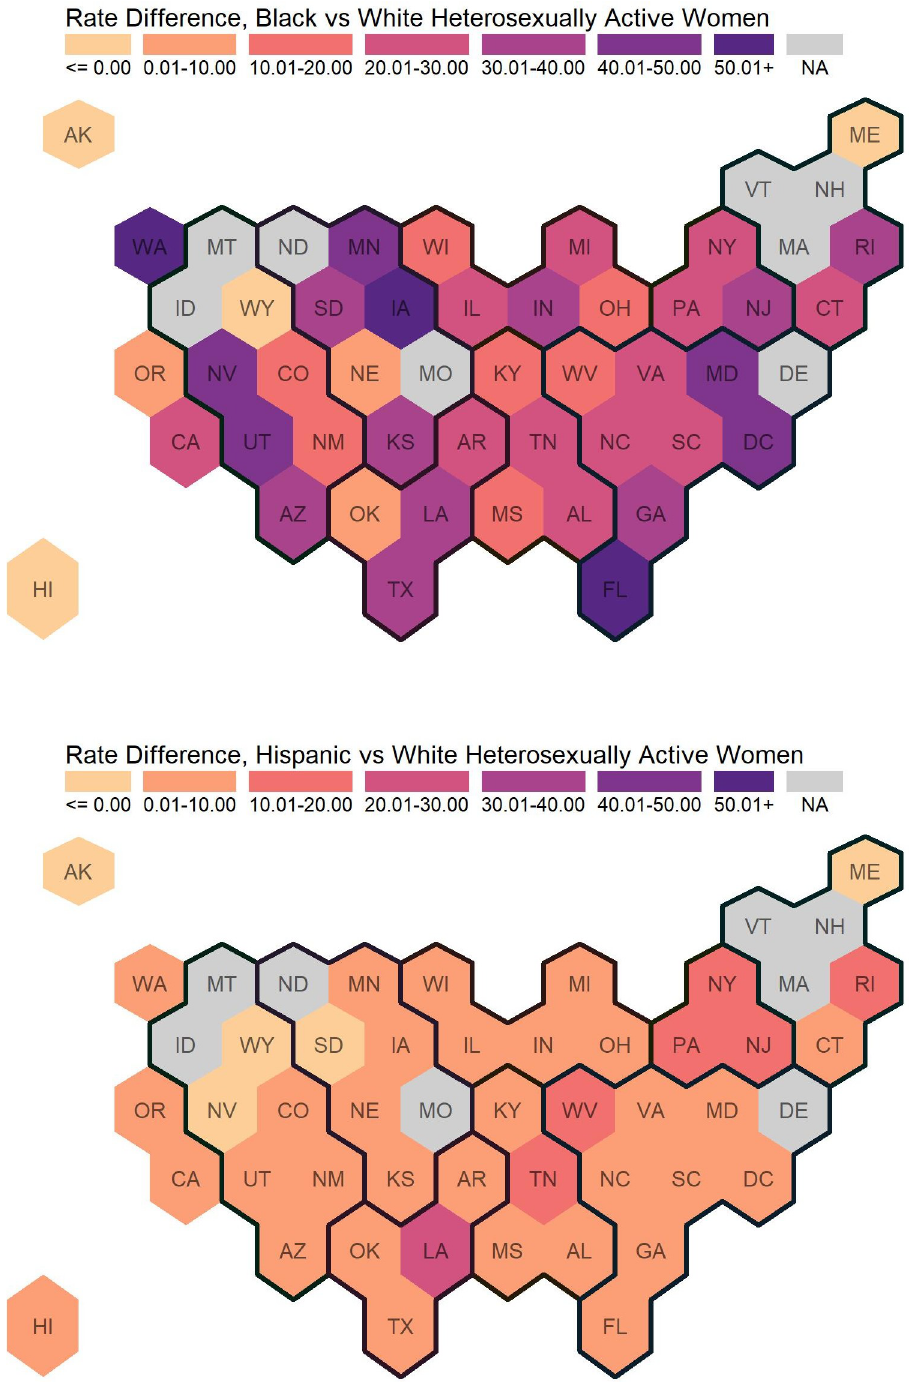
Fig 4. Rate differences of newly diagnosed HIV cases among heterosexually active Women Ages 18+. Regions are indicated with the dark black lines. Eight states did not report stratified data (by sex, transmission category, and race/ ethnicity), and are indicated with “not available”